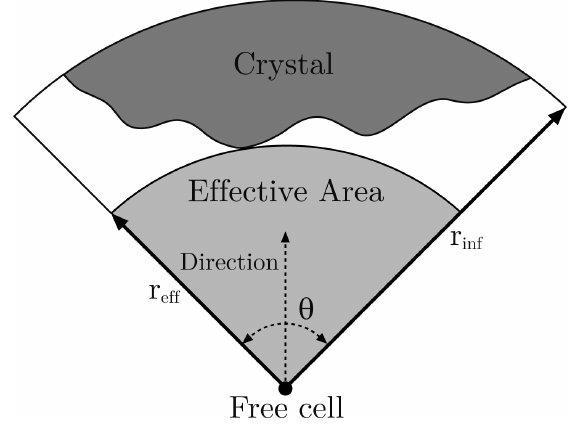
Figure 2. Effective area of a free cell in the north direction with an opening angle θ = π